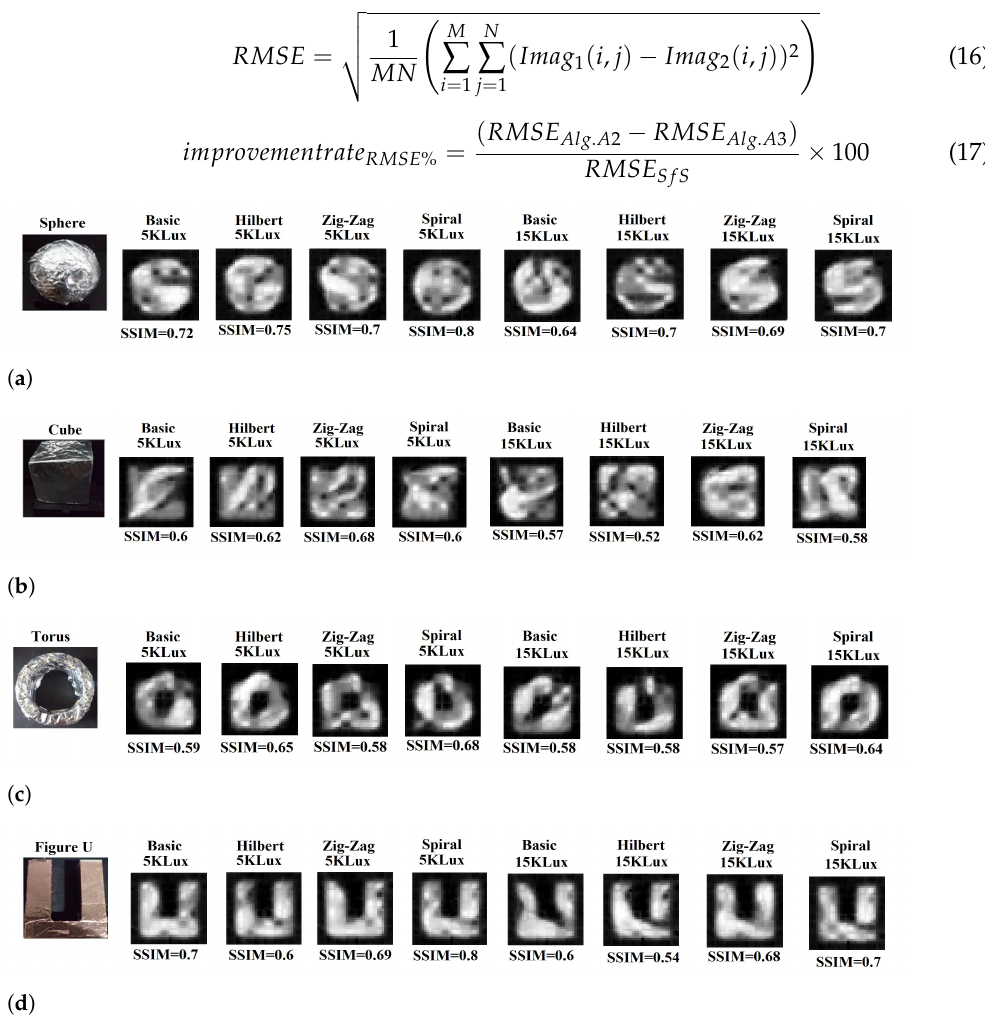
Figure 10. Reconstruction using the 2D NIR-SPI camera with active illumination at wavelength of λ = 1550 nm and object placed 20 cm from the camera for different scanning techniques under foggy conditions with particles diameter of 3 µ m and background light of 5 and 15 kLux, respectively: (ring-like object) with an external diameter of 55 mm and an internal diameter of 25 mm, and ( d ) U-shaped object with dimensions of 65 mm × 40 mm × 17